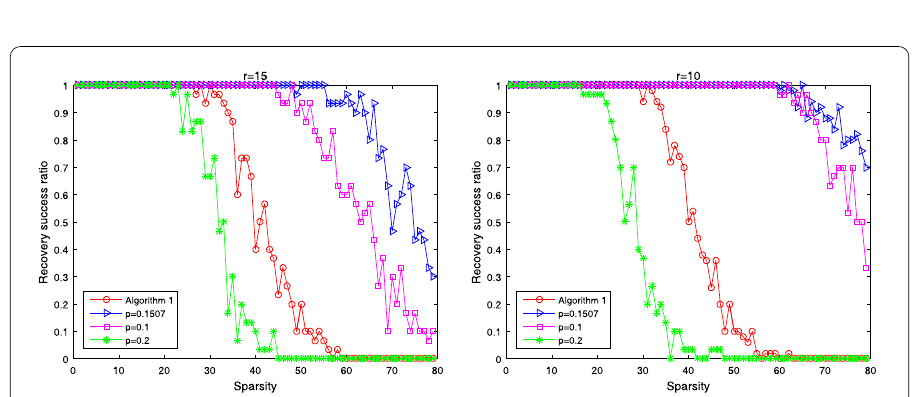
Figure 5 The result by using Algorithm 3 with different p , the left one is the situation when r = 15, the right one is the situation when r =